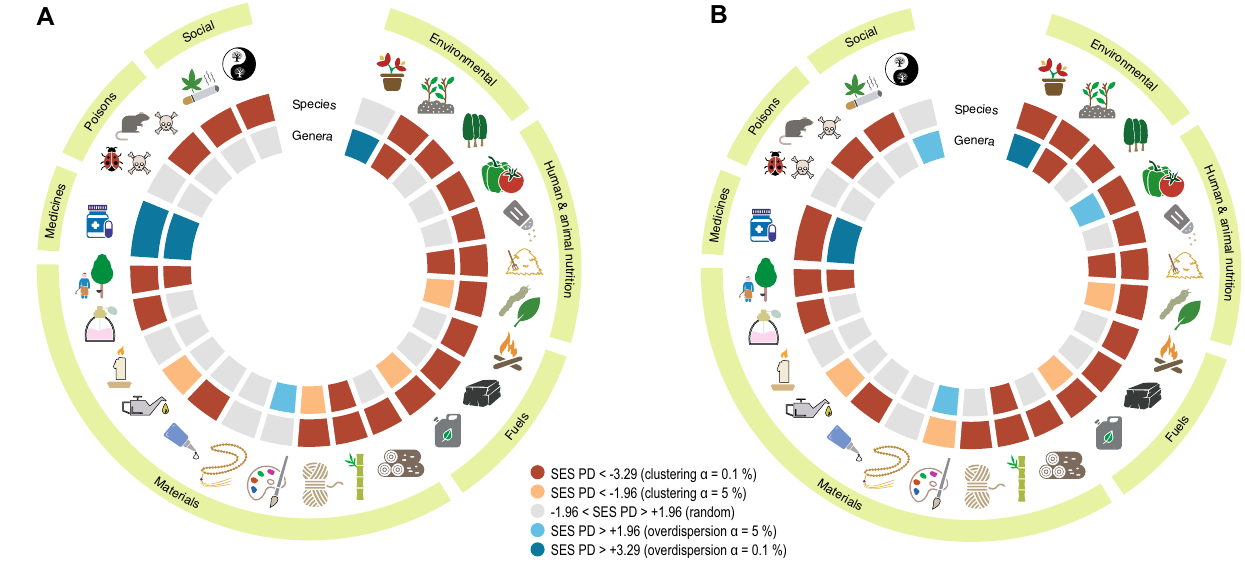
Figure 1. Types of plant benefits analyzed in the study. ( A ) and ( B ) show the results of the phylogenetic diversity (PD) analysis for the ‘full’ (all beneficial species) and ‘congeneric’ (a subset restricted to the species that showed at least one beneficial congeneric) datasets, respectively. The color of the sectors in the inner tracks represents the statistical significance of the PD tests (averaged SES PD scores, two-tailed tests) conducted for each type of benefit at the genus and species level, respectively. The exact averaged SES PD scores with 95% confidence intervals (representing phylogenetic uncertainty in SES score estimations) are provided in Supplementary Table 1, and they were considered significant for a given nominal alpha only if confidence intervals laid completely above (higher than expected) or below (lower than expected) the corresponding threshold (see legend). From twelve o’clock and clockwise: ornamental, soil improvers, hedges/shelters, human food, food additives, vertebrate food, invertebrate food, fuelwood, charcoal, biofuels, timber, cane, fibres, tannins/dyestuffs, beads, resins/gums, lipids, waxes, scents/essential oils, rubber, medicines, invertebrate poisons, vertebrate poisons, smoking materials/drugs and